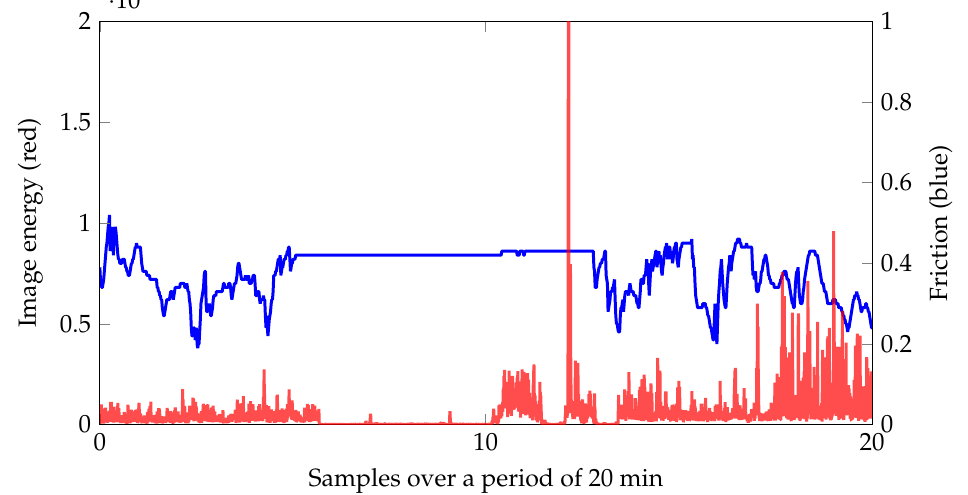
Figure 9. The plots of friction data from RCM411 in blue, and Walabot image energy in red, during a 20 min